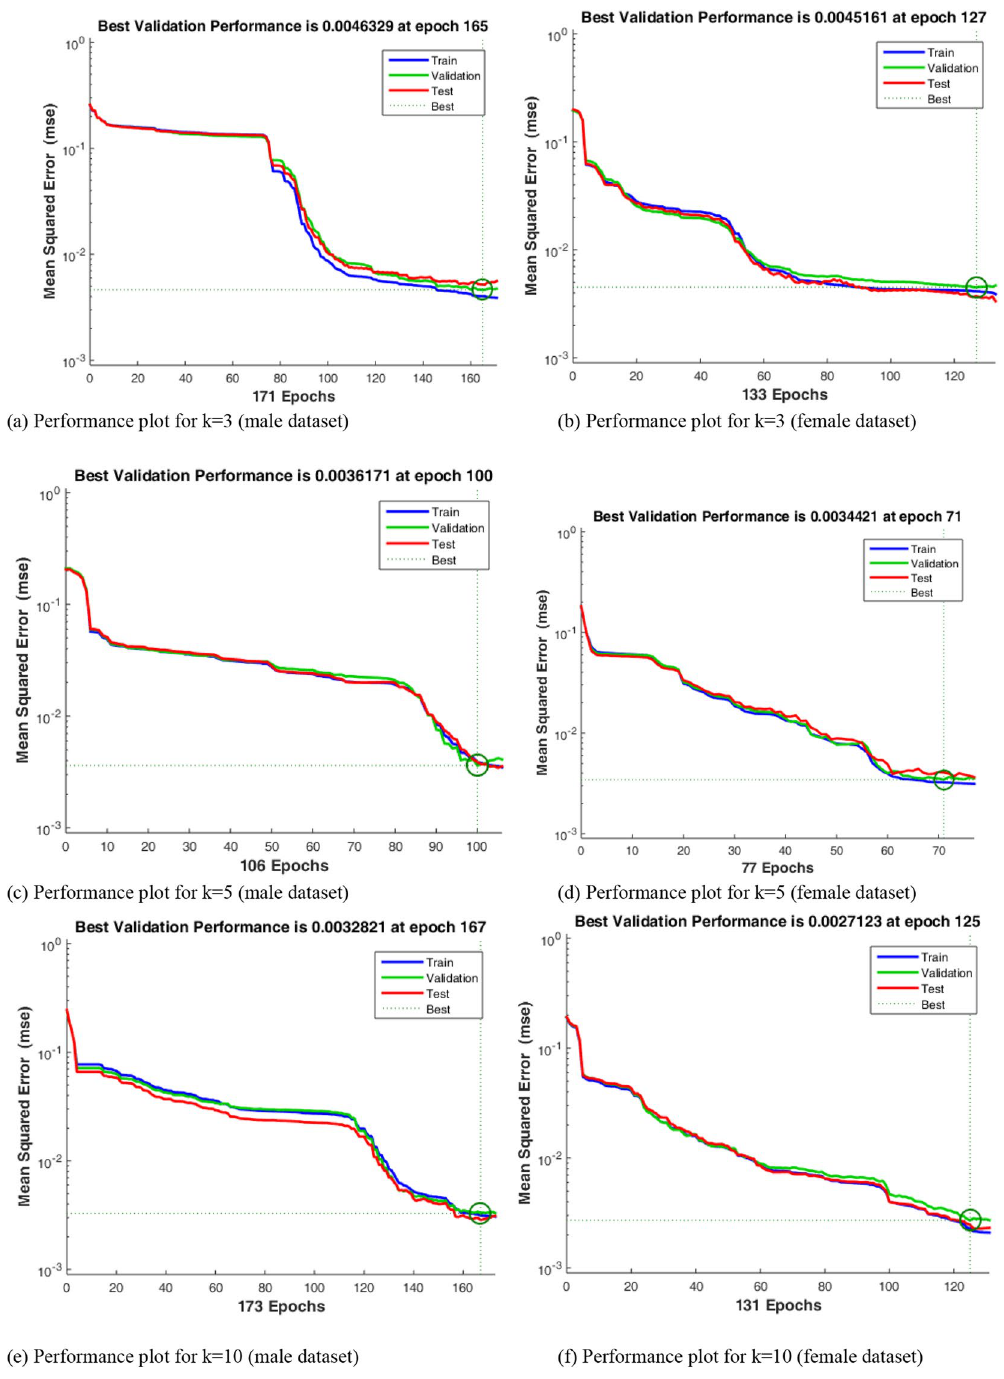
Figure 9. Neural network performance